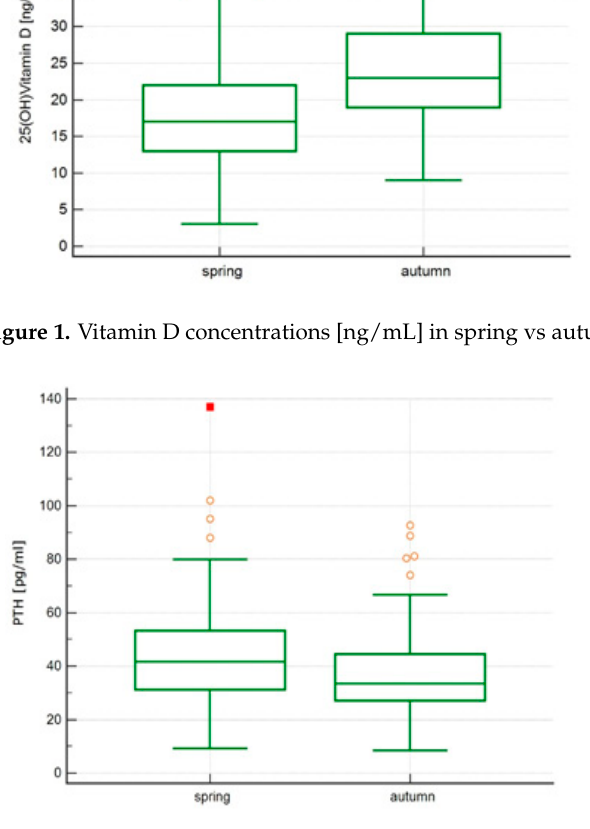
Figure 2. Parathormone (PTH) concentrations [pg/mL] in spring vs autumn. Vitamin D concentrations were higher in spring in women (19.38 ± 7.60 ng/mL (median 19.0 ng/mL) vs. 16.59 ± 6.82 ng/mL (median 15.1 ng/mL), p = 0.02), but these dif- ferences ceased to be significant in autumn, i.e., 25.37 ± 8.10 ng/mL (median 24.15 ng/mL) vs. 23.81 ± 7.11 ng/mL (median 23.11 ng/mL), p = 0.24. The summer-related increase in vi- tamin D concentrations was significant for both sexes ( p < 0.001). There were no significant differences in PTH and calcium concentrations in men vs. women, while summer-related decrease in PTH concentrations was significant for both sexes (45.46 ± 17.59 pg/mL vs. 37.21 ± 15.07 pg/mL and 43.20 ± 18.16 pg/mL vs. 36.01 ± 13.88 pg/mL, p = 0.001, and p = 0.011, for women and men,